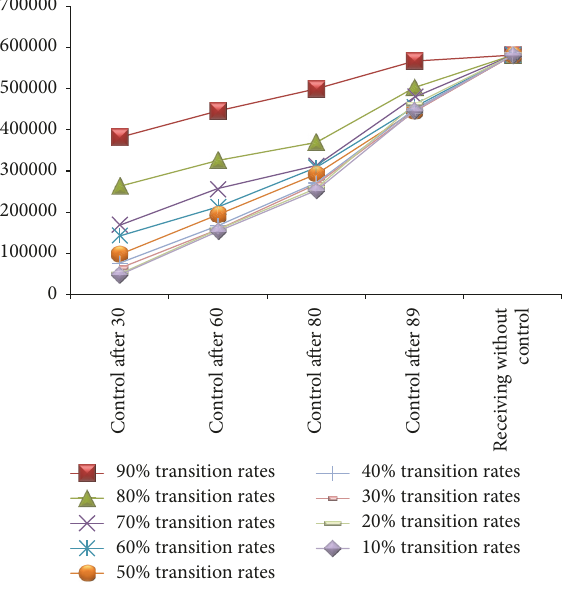
Figure 8: User transition rate, trigger point, and accumulated receiving.